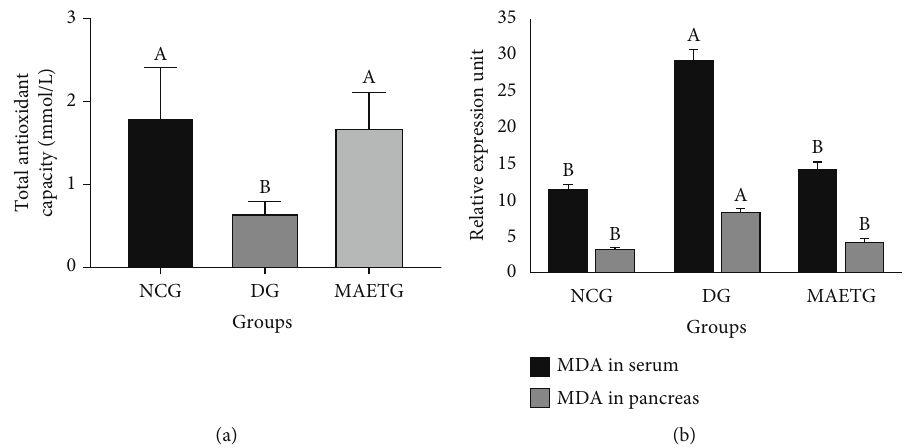
Figure 3: E ff ect of MAE on (a) TAC (total antioxidant capacity) and (b) MDA (malondialdehyde) in STZ-induced diabetic rats after 30 days of treatment. Data were presented as mean ± SD . Data were analyzed using ANOVA followed by LSD. The mean di ff erence is signi fi cant at p < 0 : 05 . Di ff erent superscript letters (A and B) denote signi fi cance while similar letters denote no signi fi cance between groups. Each group contained 10 rats.